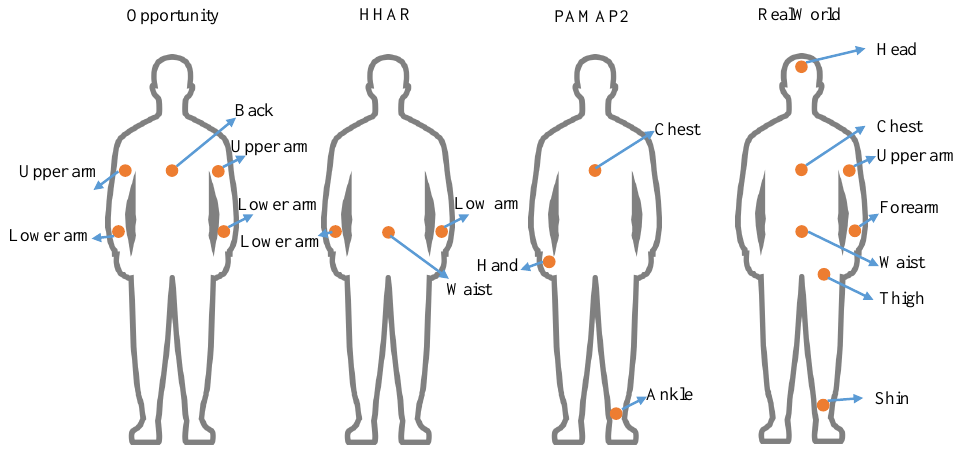
Figure 8. Placement of sensors in the Opportunity dataset [100], HHAR dataset [101], PAMAP2 dataset [102] and RealWorld dataset